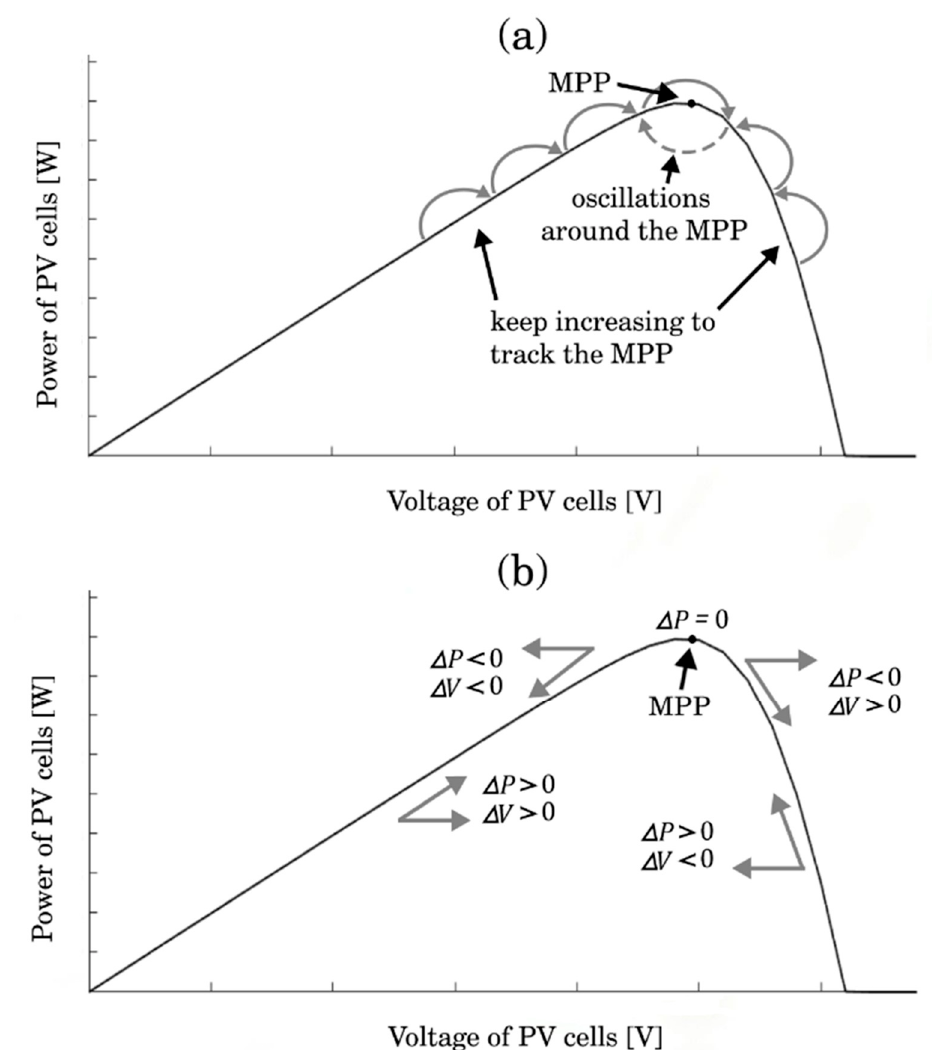
Figure 3. P&O algorithm in the voltage versus power curve: ( a ) its behavior on the curve, ( b ) cases of the algorithm.